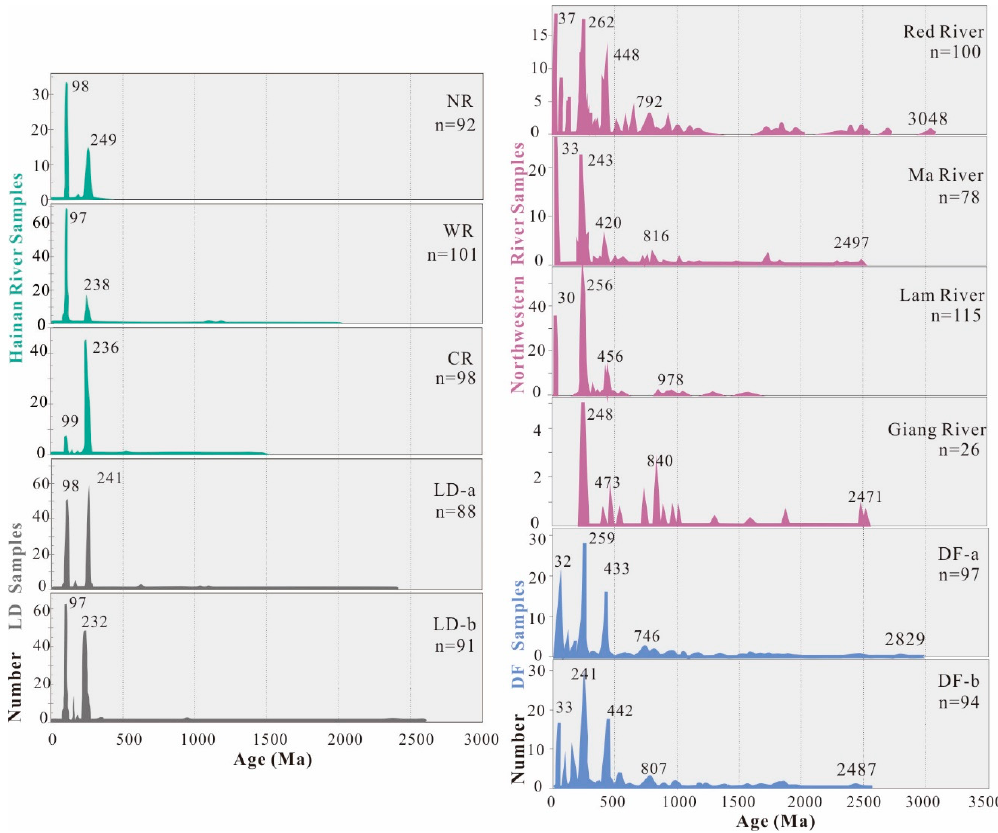
Figure 5. Detrital zircon Pb206/U238 age spectrum of Hainan River samples (green), Ledong samples (gray), northwestern river samples (purple) and Dongfang samples (blue). The “n” denotes the total number of zircons used for dating.